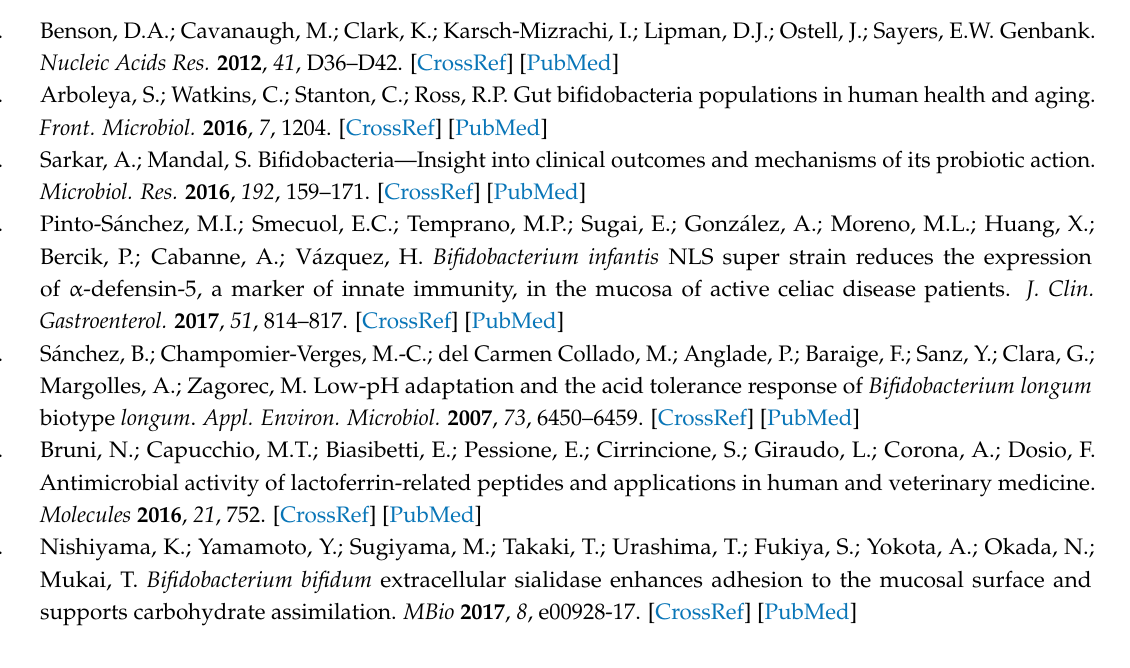
human-gut strains of bifidobacteria (PHBifs); Figure S7: An interaction network of the human innate immunity related proteins and the core proteins of the 56 probiotic and human-gut strains of bifidobacteria (PHBifs); Table S1: A list of the 74 recognized bifidobacterial species available at the NCBI Taxonomy database; Table S2: A list of the 215 members of the genus Bifidobacterium with publically available genomes (complete and draft); Table S3: The power and the exponential fit law implemented in BPGA pipeline to find out the estimated size of the core-genome and the open/close nature of the pan-genome for the 215 members of the genus Bifidobacterium ; Table S4: A list of the genes (gene IDs of B. kashiwanohense JCM 15439) present in the core-genome of the 215 members of the genus Bifidobacterium ; Table S5: The power and the exponential fit law implemented in BPGA pipeline to find out the estimated size of the core-genome and the open/close nature of the pan-genome for the 56 probiotic and human-gut strains of bifidobacteria (PHBifs); Table S6: A list of the genes and their corresponding functions present in the core-genome of the 56 probiotic and human-gut strains of bifidobacteria (PHBifs); Table S7: The genome-sizes and abundances of the mobile genetic elements present in the genomes of the 56 probiotic and human-gut strains of bifidobacteria (PHBifs); Table S8: The correlation statistics of the mobile genetic elements of the 56 probiotic and human-gut strains of bifidobacteria (PHBifs); Table S9: The correlation statistics of the genome-sizes versus the abundances of COGs classes present in the genomes of the 56 probiotic and human-gut strains of bifidobacteria (PHBifs); Table S10: The KEGG pathway functions (level-I) of the pan-genome of the 56 probiotic and human-gut strains of bifidobacteria (PHBifs); Table S11: The KEGG pathway functions (level-II) of the pan-genome of the 56 probiotic and human-gut strains of bifidobacteria (PHBifs); Table S12: A list of the human proteins and the core proteins of the 56 probiotic and human-gut strains of bifidobacteria (PHBifs) predicted to be interacting with each other; Table S13: Detailed functions of the core proteins of the 56 probiotic and human-gut strains of bifidobacteria (PHBifs) predicted to be interacting with the human proteins; Table S14: A list of the core proteins of the 56 probiotic and human-gut strains of bifidobacteria (PHBifs) interacting with each other; Table S15: A list of the core proteins of the 56 probiotic and human-gut strains of bifidobacteria (PHBifs) predicted to be interacting with the human innate immunity related proteins; Table S16: The KEGG pathway information of the human immune related proteins interacting with the core proteins of the 56 probiotic and human-gut strains of bifidobacteria